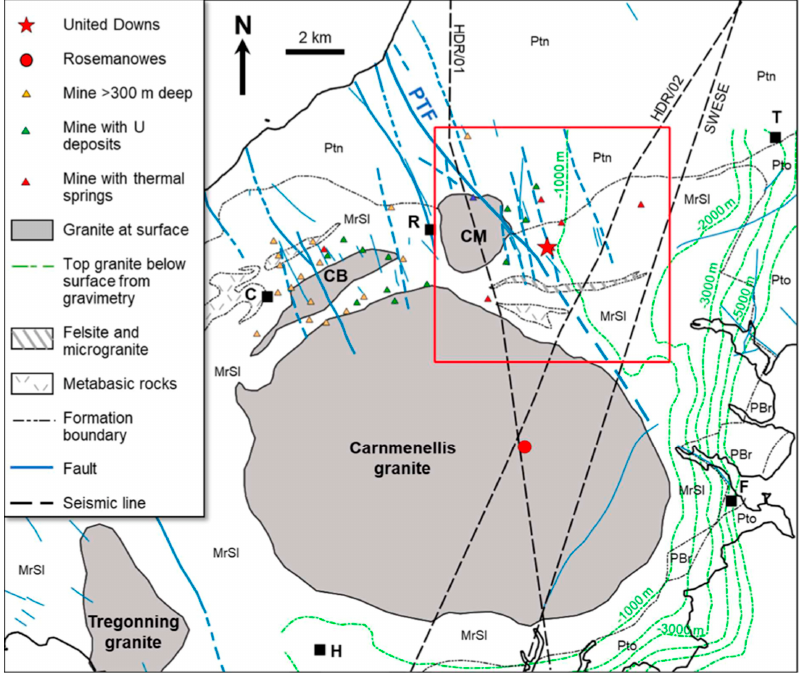
Figure 2. Geological map of the region. Isolines of top granite are not displayed on the western and northern sides of the Carnmenellis granite. The red square indicates the UDDGP model outline. Ptn: Porthtowan Formation, MrSl: Mylor Slate Formation, PBr: Porthleven Breccia Member, Pto: Portscatho Formation, all Devonian in age. Towns: T: Truro, F: Falmouth, R: Redruth, C: Camborne, H: Helston [11].